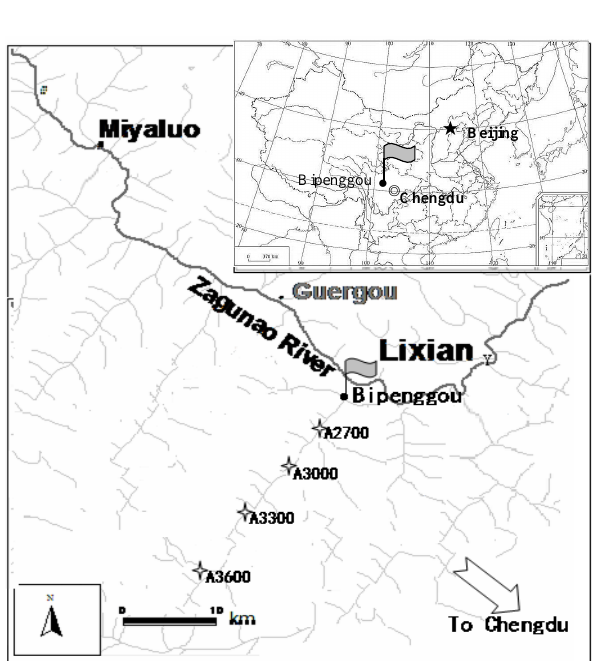
Figure 1. Location of sampling sites in the eastern Qinghai–Tibetan Plateau, China. A2700, A3000, A3300 and A3600 show the sam- pling sites along an altitudinal gratitude from 2700 to 3600m with similar slope and direction at